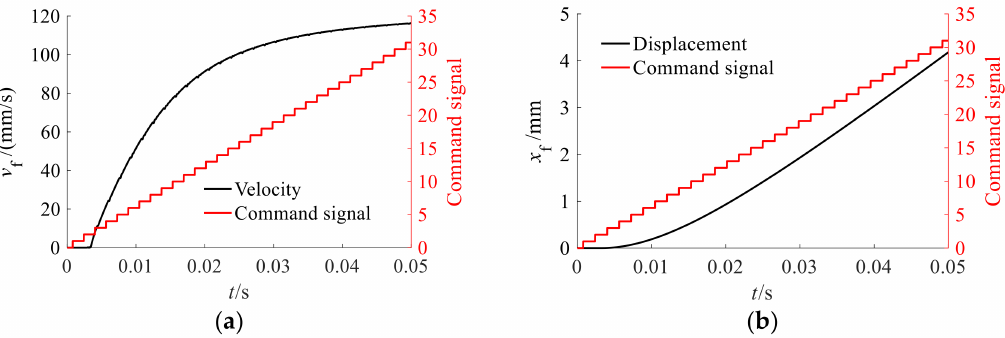
Figure 6. Open-loop characteristics of the fuel metering valve: ( a ) Velocity; ( b )